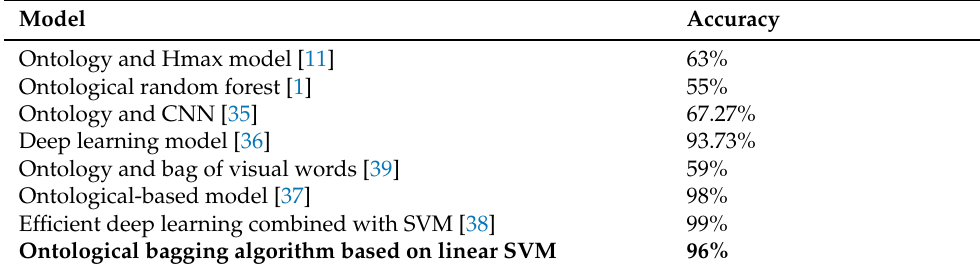
Table 7. Accuracy obtained from other